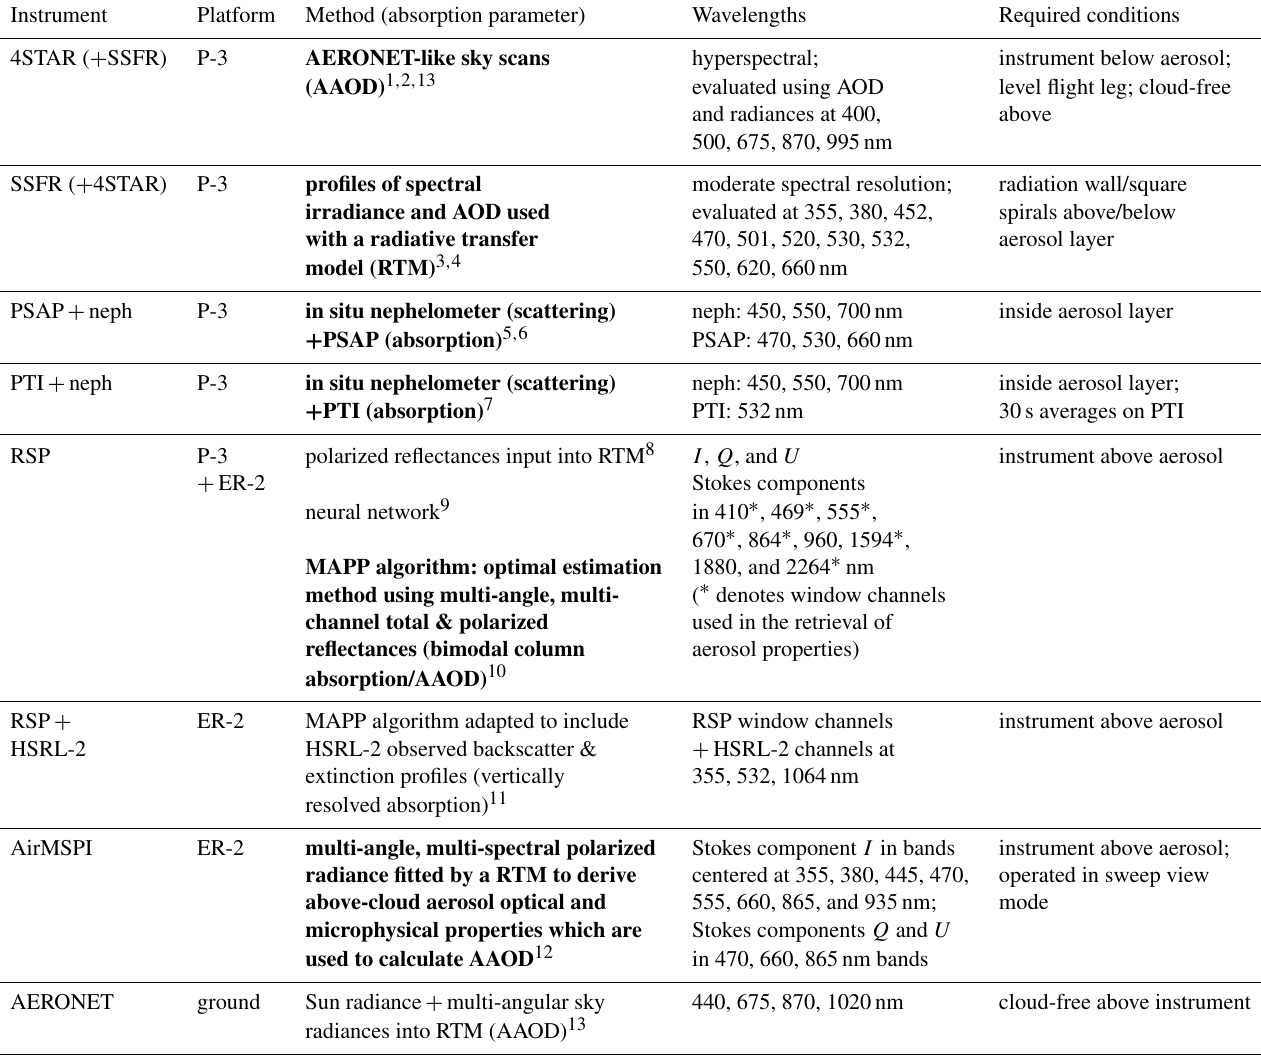
Table 1. Overview of ORACLES instruments, as used to quantify SSA during the ORACLES campaigns, and the method used. Not all measurement approaches are included in this paper; some are still in process and will be presented in future publications. Instruments/methods presented in this paper are indicated in bold. Full archival data citations are given at the end of the paper under “Code and data